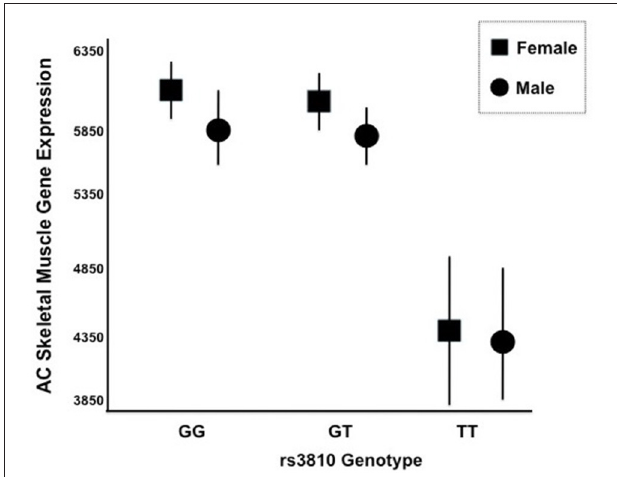
FIGURE 5 | mRNA Expression of ASAH1 Stratified by rs3810 Genotype. Two distinct Affymetrix probe sets indicated that ASAH1 mRNA expression is significantly different by rs3810 genotype using either full ( p = 0.006–0.007) or dominant ( p = 0.01–0.02) models, using sex and race as covariates. Females are represented by rectangles and males are represented by circles. TT individuals demonstrated 1.3–1.4 times lower skeletal muscle acid ceramidase expression than did GG individuals at